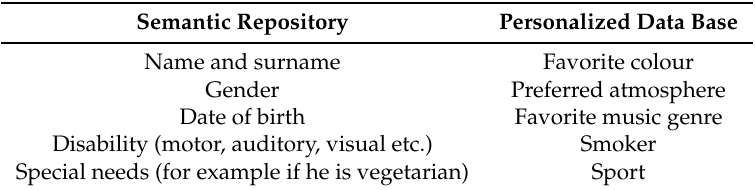
Table 1. Passenger’s characteristics.